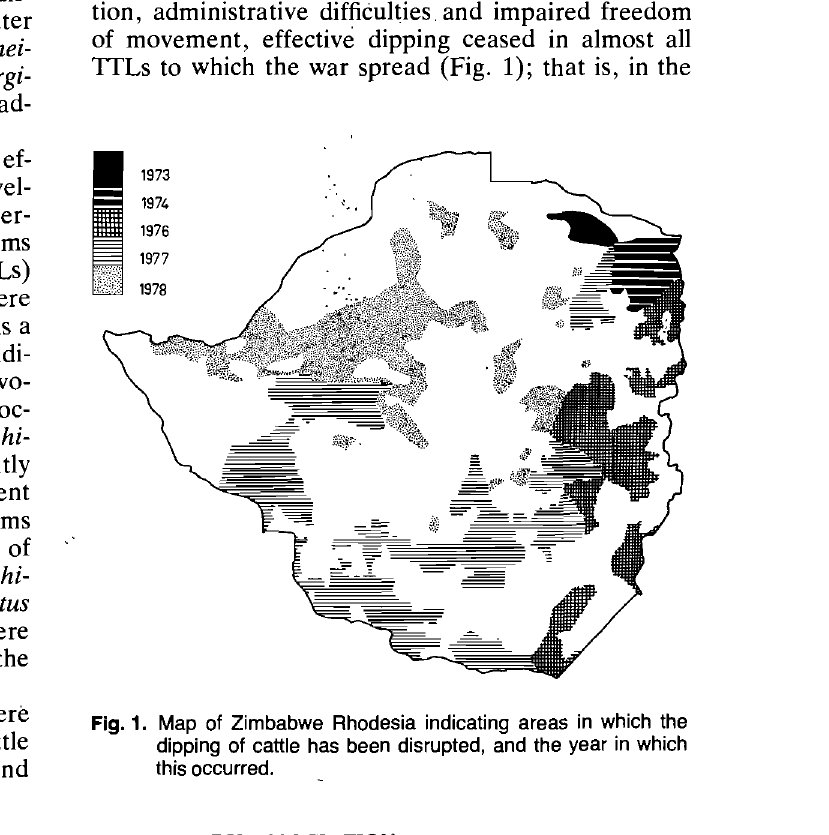
Fig. 1. Map of Zimbabwe Rhodesia indicating areas in which the dipping of cattle has been disrupted, and the year in which this